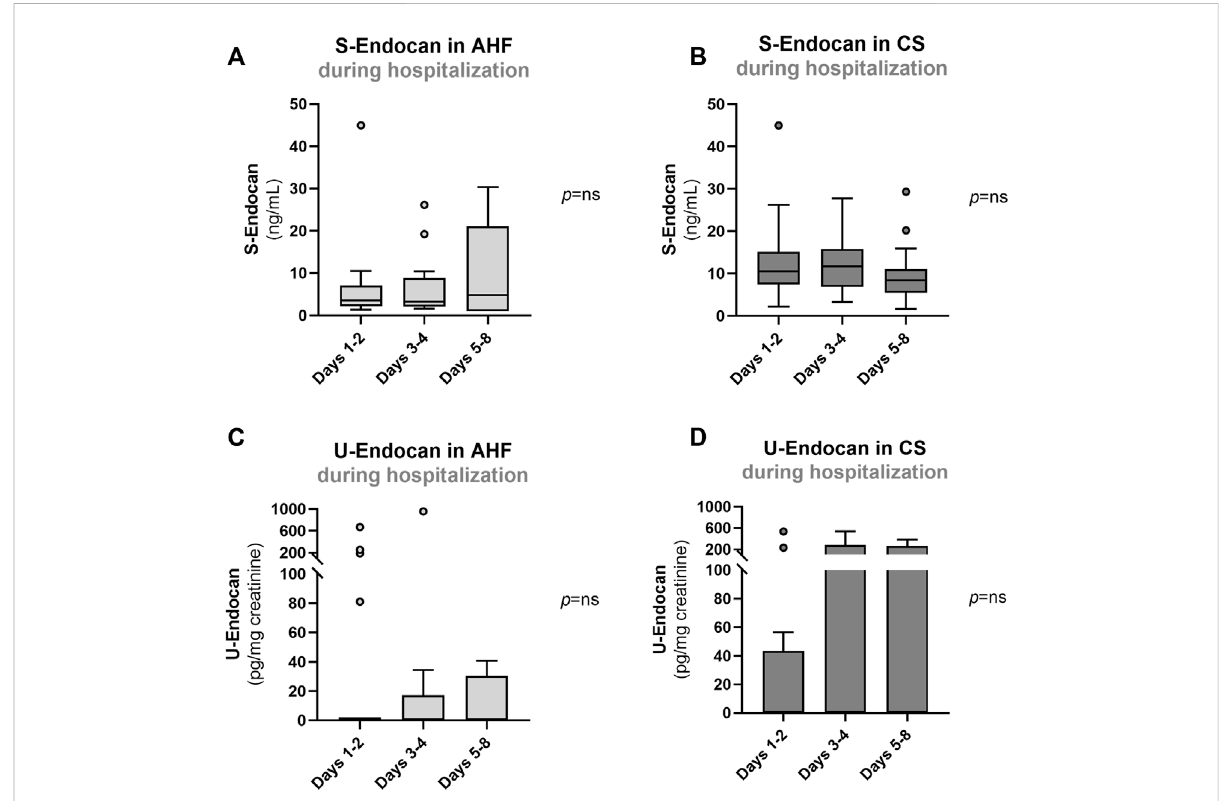
FIGURE 2 Serum (A, B) and urinary endocan (C, D) at days 1 – 2, days 3 – 4 and 5 – 8 in patients with AHF or with CS. Results are presented in Box-and- Whiskers plot. AHF, acute heart failure; CS, cardiogenic shock; S-Endocan, serum endocan; U-Endocan, urinary